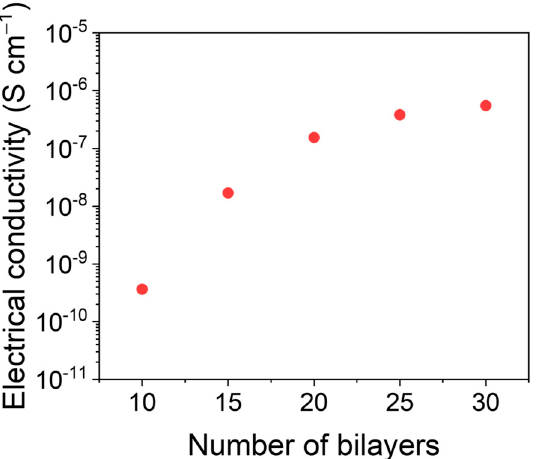
Figure 3. Electrical conductivity as a function of the number of bilayers of MWCNTs onto felt